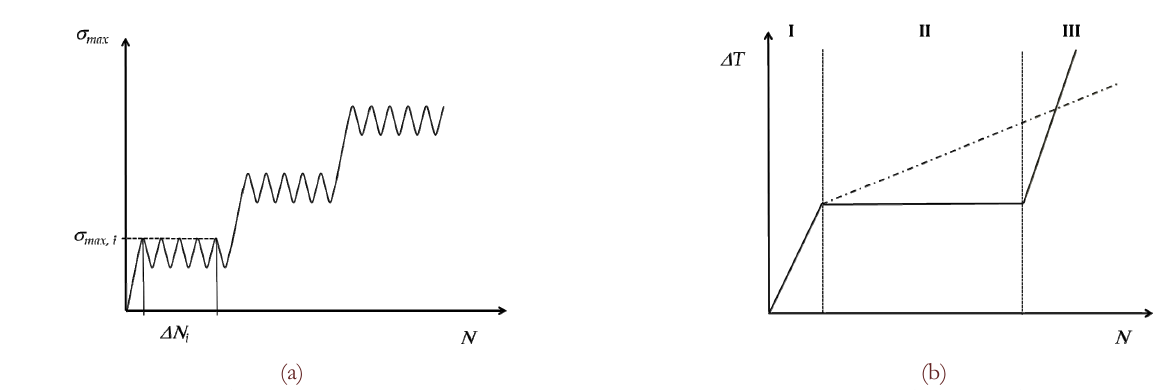
Figure 4: a) Stepwise loading history. The characteristics of each interval (i.e. maximum applied stress and length of the interval) depend on the tested material. b) Thermal profile in each interval: the temperature characterized by an initial linear increasing region (I), represented with a black continuous line, then followed by a second linear region –represented by a back dashed line- or by a plateau region (region II, represented by a continuous black line) and a final increasing region (region II, represented by a continuous black